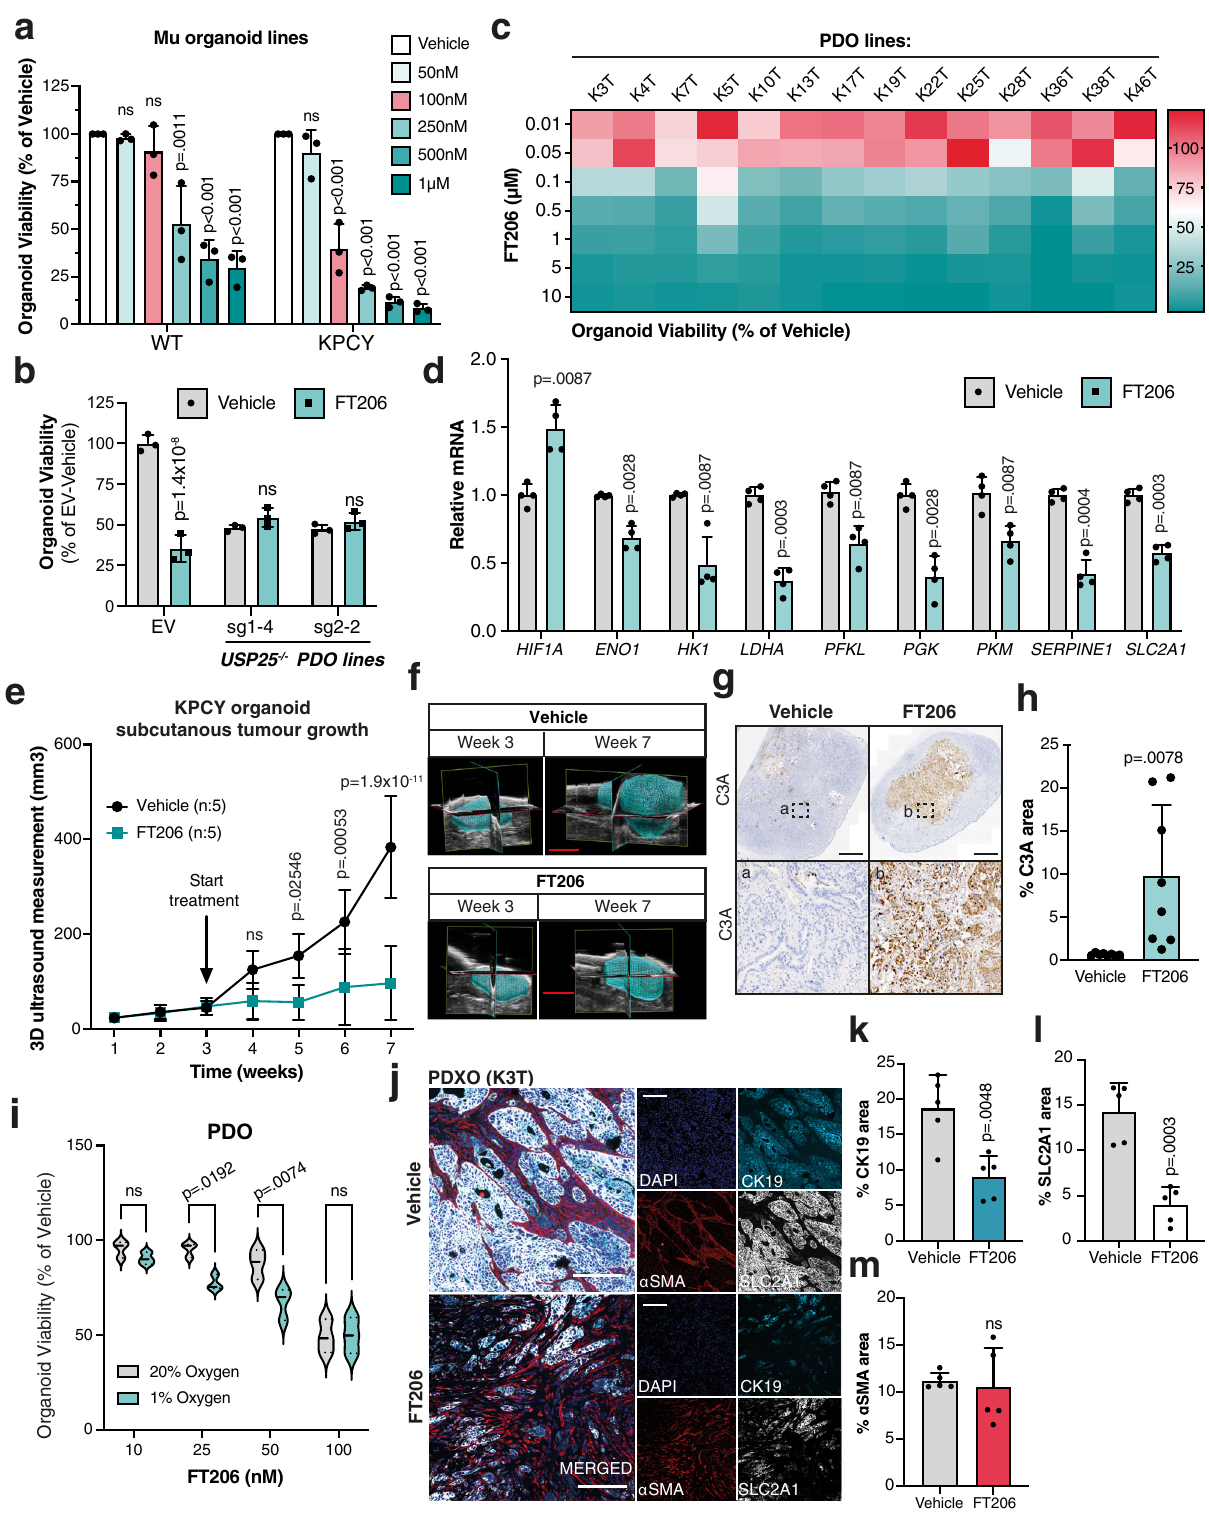
key glycolytic enzymes and the glucose transporter SLC2A1. Interestingly, neither USP25 nor SLC2A1 were detected in the surrounding stroma compartment, nor did we observe changes in the stroma marker α SMA upon FT206 treatment. Our fi ndings suggest that the USP25-HIF-1 α -glycolytic axis is a speci fi c requirement and potential therapeutic vulnerability for PDAC tumor cells. Whether PDAC tumor cells are therapeutically